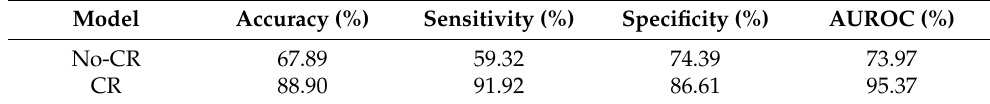
Table 2. Performance of the RFC model trained without CR and trained only with CR.